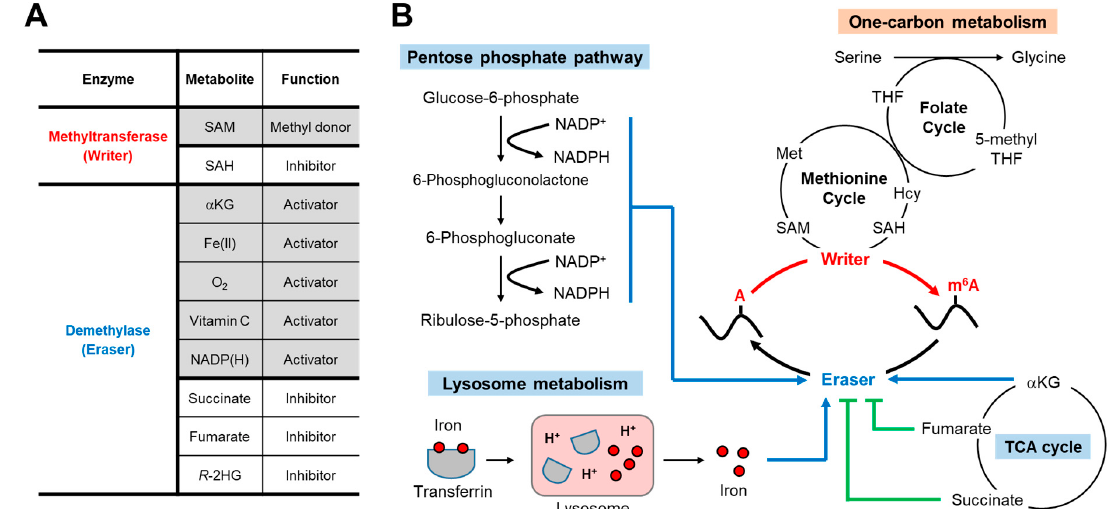
Figure 2. Potential interplay of m 6 A methylation with cellular metabolic pathways. ( A ) List of metabolites affecting activities of m 6 A writers and erasers. Grey, activators; white, inhibitors. ( B ) Schematic of metabolic pathways that can influence m 6 A methylation and demethylation processes. One-carbon metabolism produces SAM, a methyl donor of m 6 A modification. S -adenosyl homocysteine (SAH), the by-product of methylation, inhibits writer activity. On the other hand, the oxidative demethylation of m 6 A by erasers needs α -ketoglutarate ( α KG), oxygen (O 2 ), and iron [Fe(II)] as cofactors. Tricarboxylic acid (TCA) cycle produces co-factors that activate ( α KG) or inhibit (fumarate and succinate) demethylase activity. Iron is delivered to cells as transferrin–iron complex, wherein low lysosomal pH causes release of free iron ions into the cytoplasm. Pentose phosphate pathway converts nicotinamide adenine dinucleotide phosphate (NADP + ) to NADPH, another cofactor for demethylases. R -2HG, R -2-hydroxyglutrate; Met, methionine; THF, tetrahydrofolate; Hcy,